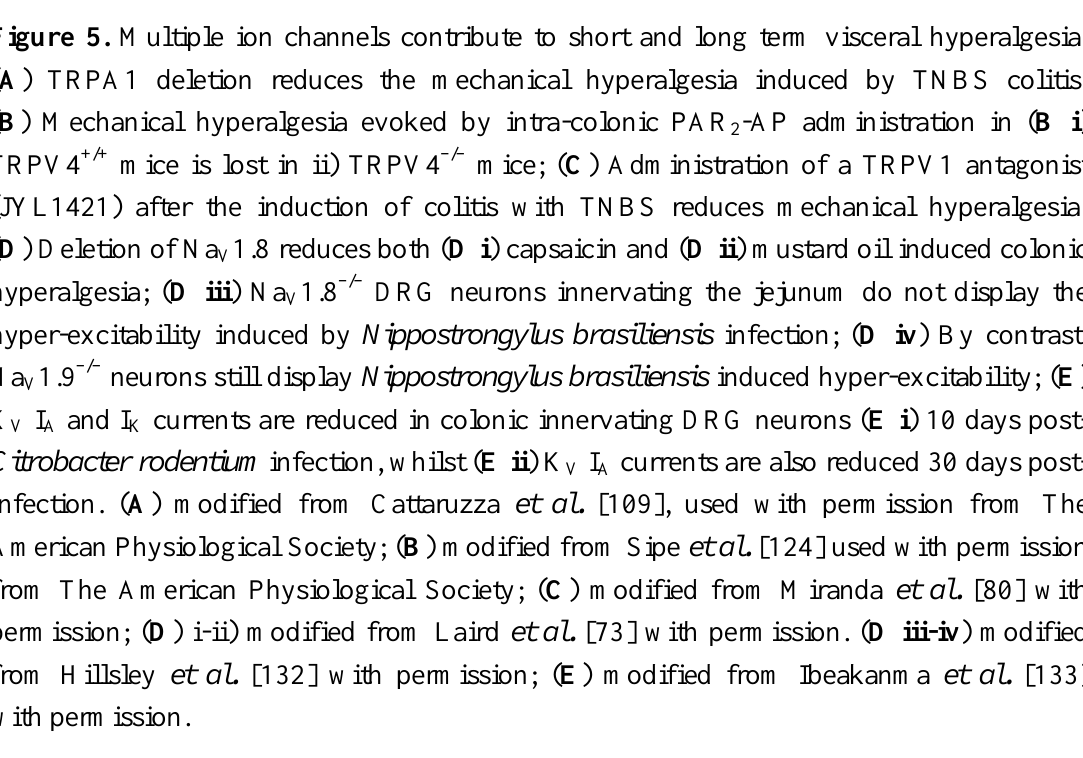
Figure 5. Multiple ion channels contribute to short and long term visceral